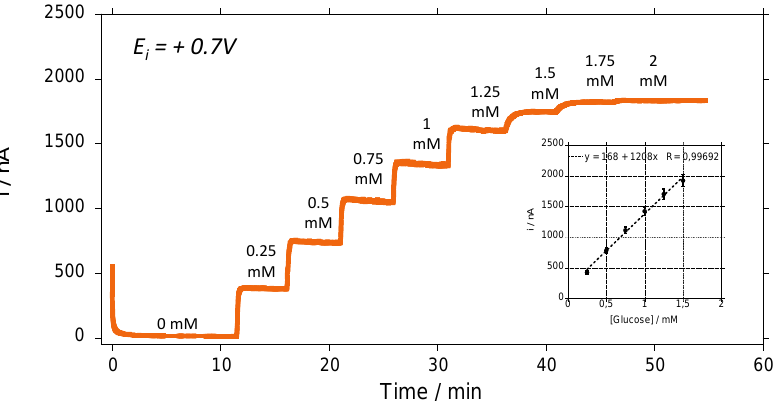
Figure 3. Amperometric responses at + 0.7 V vs. Ag/AgCl of glucose biosensing) in PBS(1X) medium under hydrodynamic conditions of 200 rpm. Inset: calibration curve of glucose during electrochemical oxidation (average value and standard deviation on 3 electrodes).